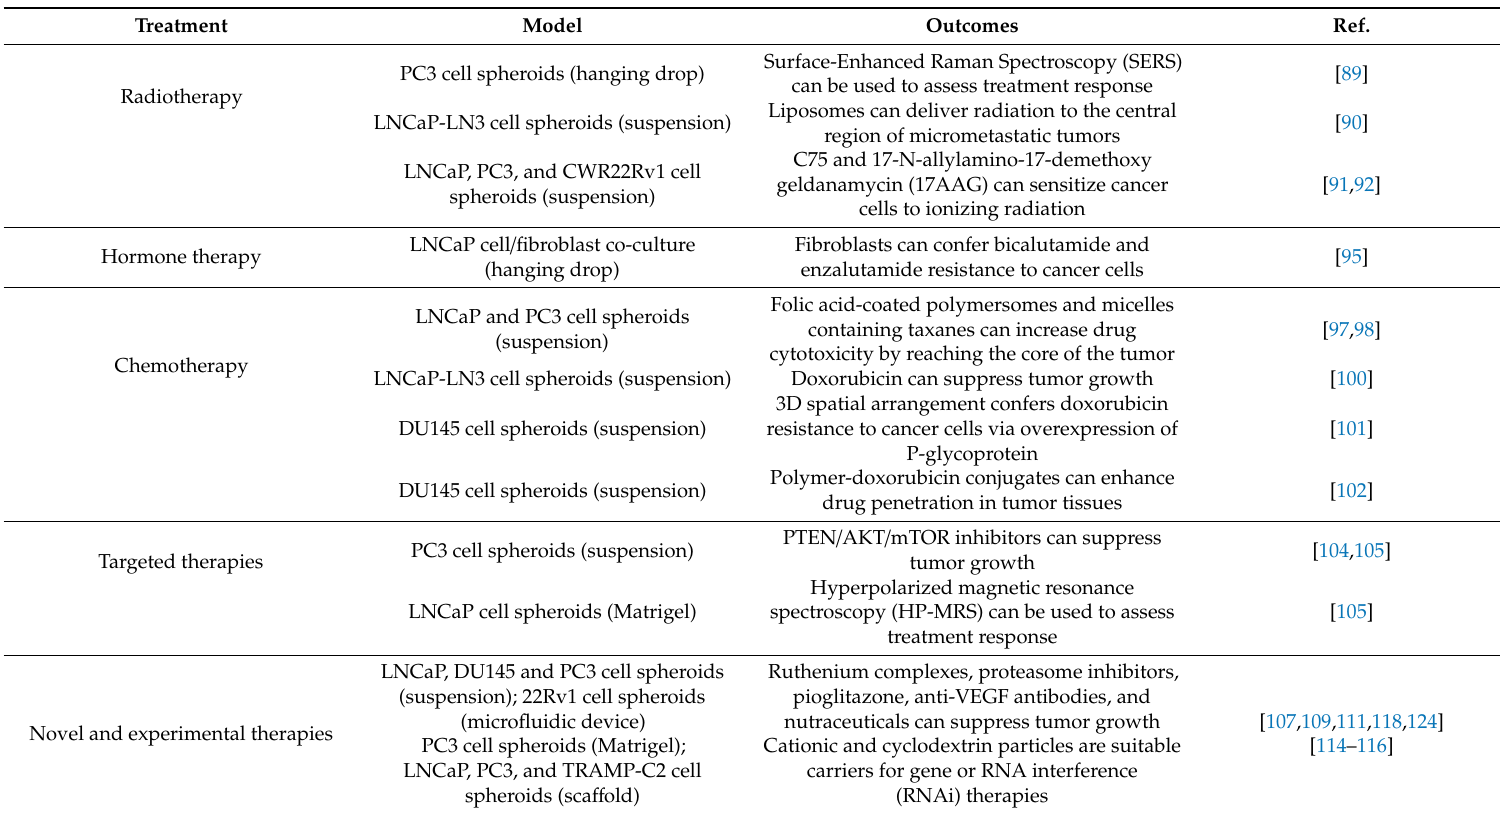
Table 2. 3D PCa cell cultures in drug discovery and